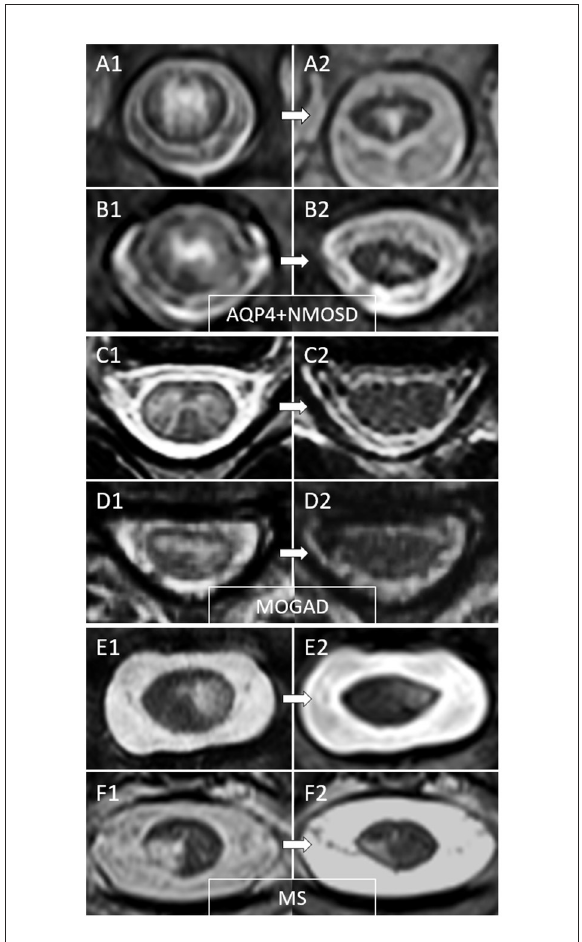
FIGURE3 Examples of temporal evolution of T2-lesions axially on spinal cord MRI in AQP4-IgG-positive neuromyelitis optica spectrum disorder (AQP4 + NMOSD), MOG-IgG-associated disease (MOGAD), and multiple sclerosis (MS). Acute myelitis lesions